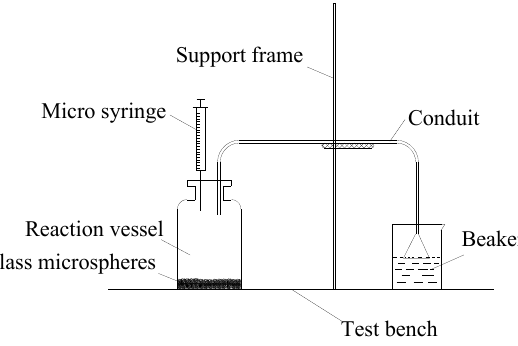
Figure 3. A schematic of the setup used for the surface modification of the glass microspheres.